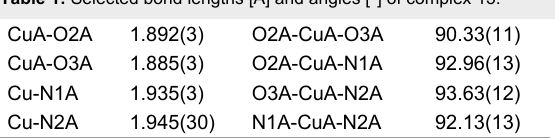
Table 1: Selected bond lengths [Å] and angles [°] of complex